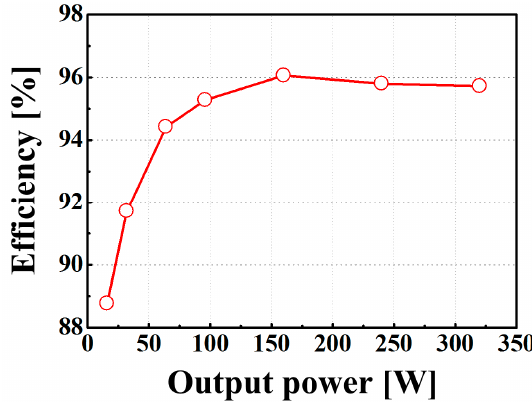
Figure 17. Power conversion efficiency ɳ e measured at V IN = 34 V and v grid = 220 V rms / 60 Hz.